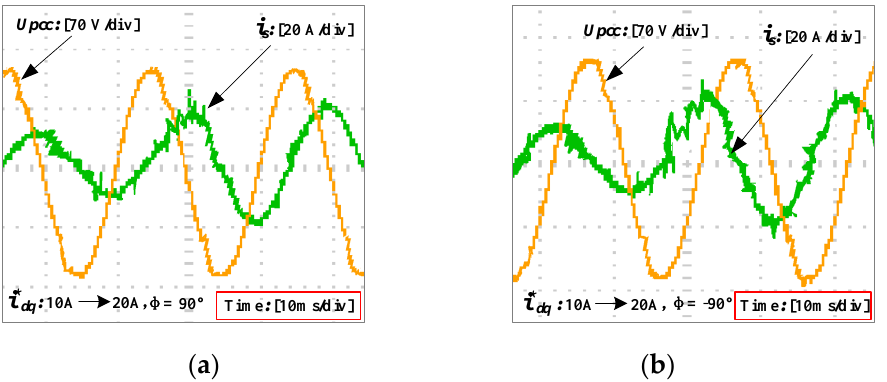
Figure 16. Waveforms of U PCC and i s with PLL when Z g = 1.8 mH. ( a ) i * φ = 90°; ( b ) i * changes from 10 A to 20 A, φ = − 90°. dq